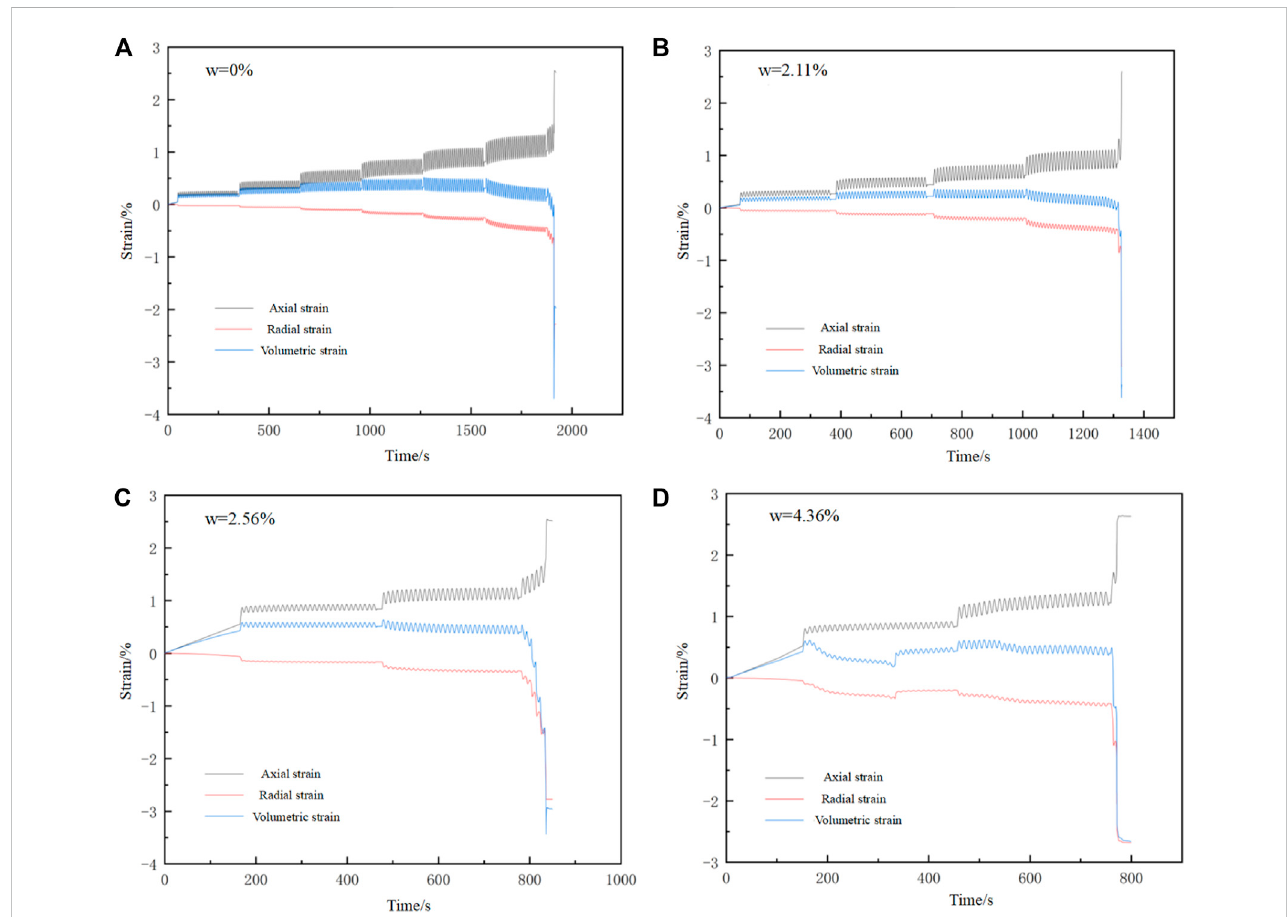
FIGURE 6 Deformation evolution characteristics (A-D) Plots of the axial, radial and volumetric strain for rock with water content of 0%, 2.21%, 2.56%, and 4.36%, respectively).